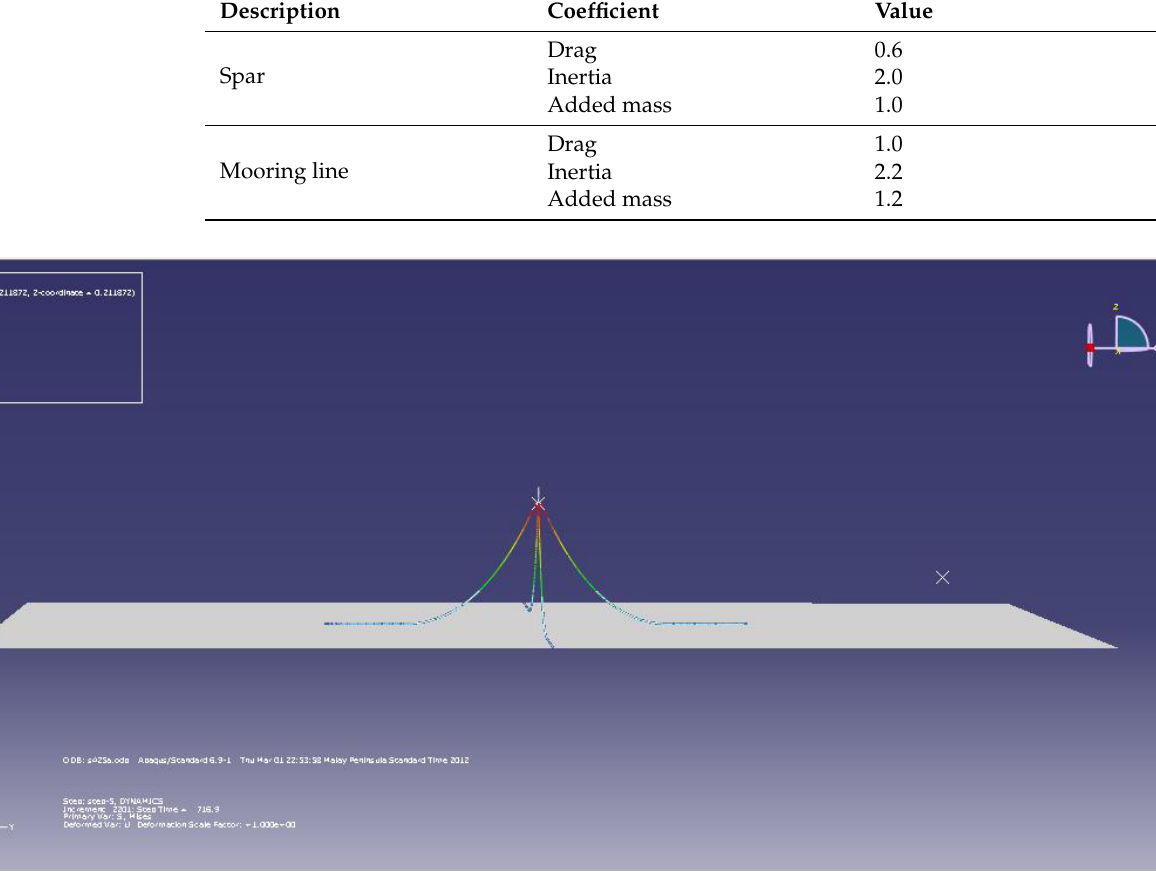
Figure 1. Two-dimensional finite element model of the spar platform in ABAQUS.